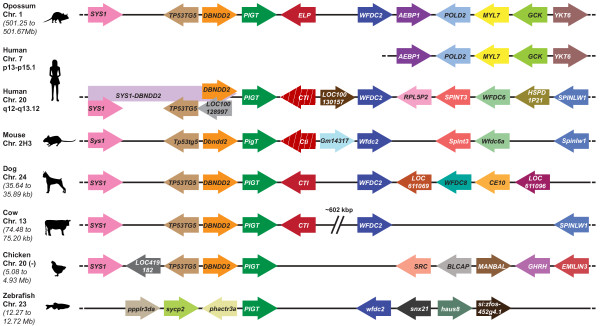
Chromosomal location of theELP/CTIgene in different species. The ELP/CTI gene was located within a syntenic block on opossum Chr. 1 (~501.34 Mb), human Chr. 20q12-13.12, mouse Chr. 2 H3, dog chr. 24 (~35.7 Mb) and cow Chr. 13 (~74.5 Mb) [49,55]. However, ELP/CTI was reduced to a pseudogene in the human and mouse (red arrow, white diagonal stripes) and was absent in the chicken and zebrafish. The ELP/CTI gene was located on the reverse strand and was generally flanked by one, or both of the single-copy genes PIGT and WFDC2. The region upstream of PIGT was conserved in mammals and the chicken and included the SYS1 [Golgi-localized integral membrane protein homolog (S. cerevisiae)], TP53TG5 (TP53-target gene 5 protein), and DBNDD2dysbindin (dystrobrevin binding protein 1) domain containing 2 genes. However, a chromosomal breakpoint was located downstream from the eutherian WFDC2 gene. Opossum chromosome 1 contained the AEBP1 (Adipocyte enhancer binding protein 1), POLD2polymerase (DNA directed), delta 2, regulatory subunit 50 kDa, MYL7 (myosin, light chain 7, regulatory) and YKT6YKT6 v-SNARE homolog (S. cerevisiae)] genes and was orthologous to human chromosome 7p13-p15.1. In contrast, the eutherian chromosomes contained a number of genes which encoded Kunitz and/or WAP domains. These included SPINT3SPINLW1WFDC8 and WFDC6, which were likely to have arisen by gene and domain duplications [62]. Notably, there was an insert of ~602 kb between bovine CTI and WFDC2. Arrows indicate the arrangement and orientation of genes and are not drawn to scale.